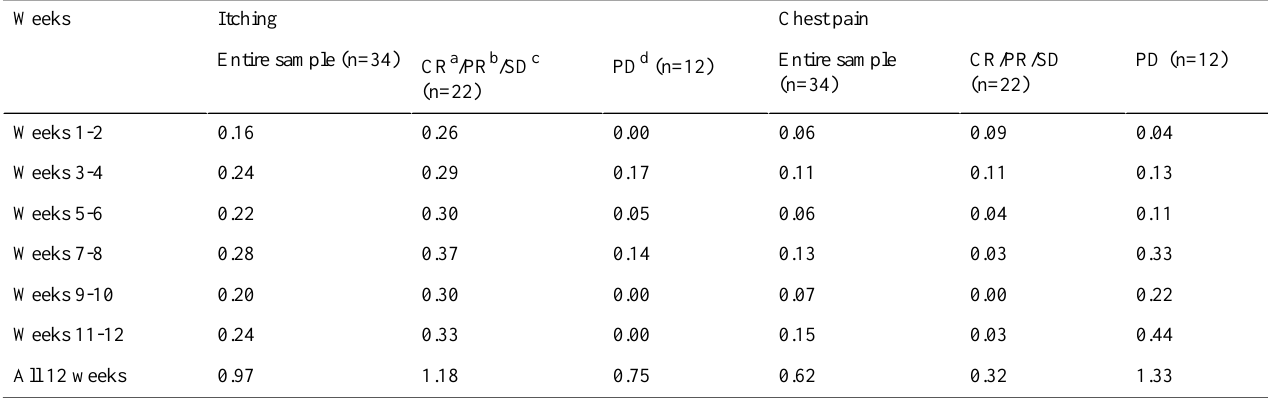
Table 6. Average grade of itching and chest pain reported by patients.